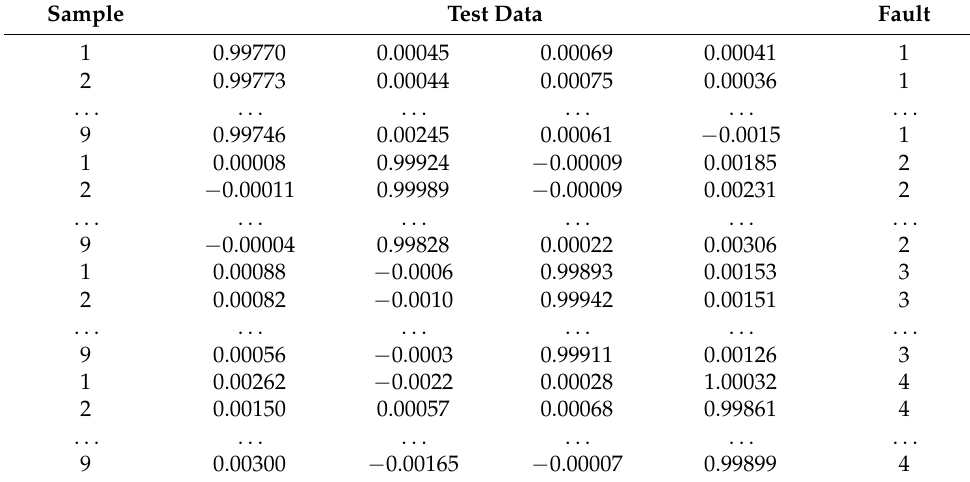
Table 3. GA-BP algorithm test